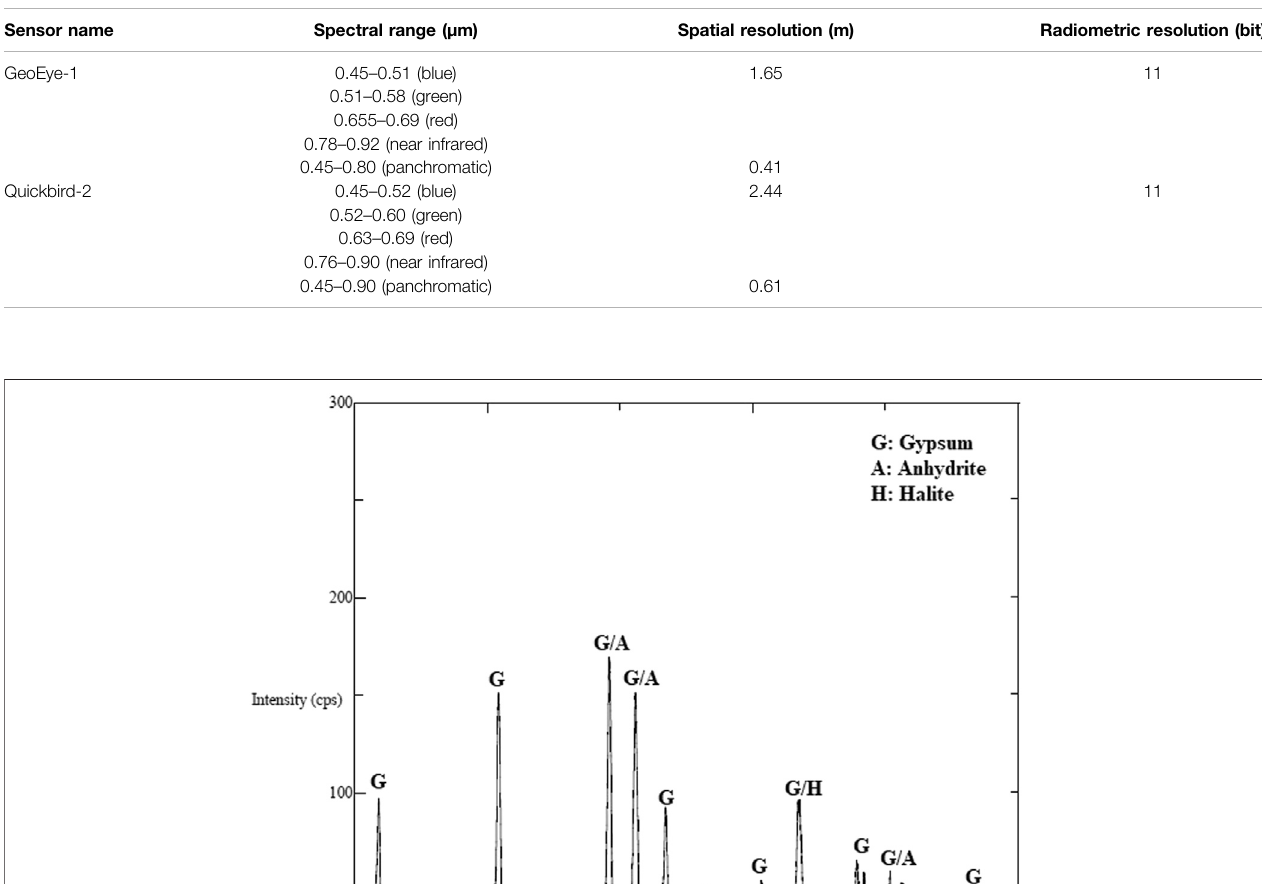
TABLE 1 | The spectral properties of GeoEye-1 and Quickbird-2 data.